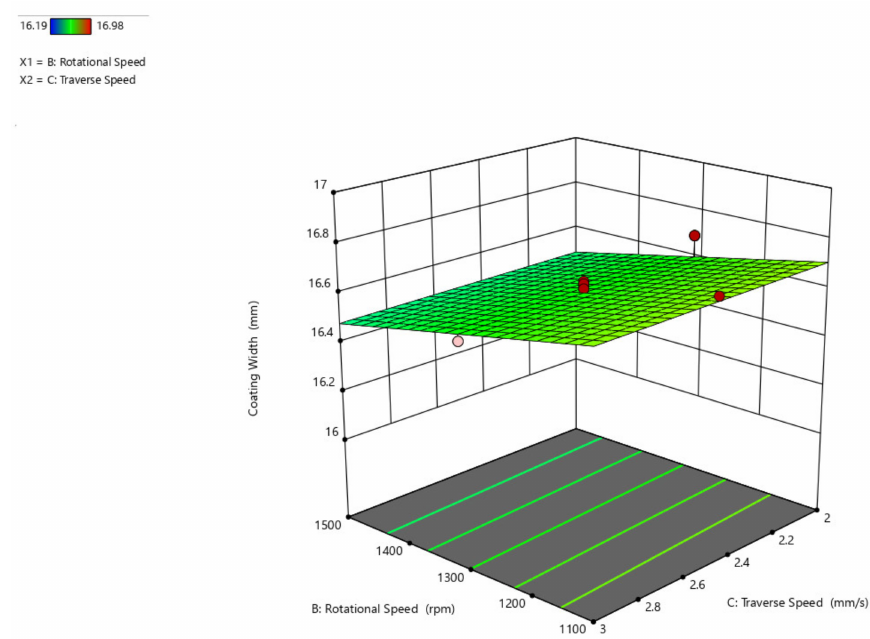
Figure 10. Interaction plot of traverse speed and rotational speed on coating width (C w